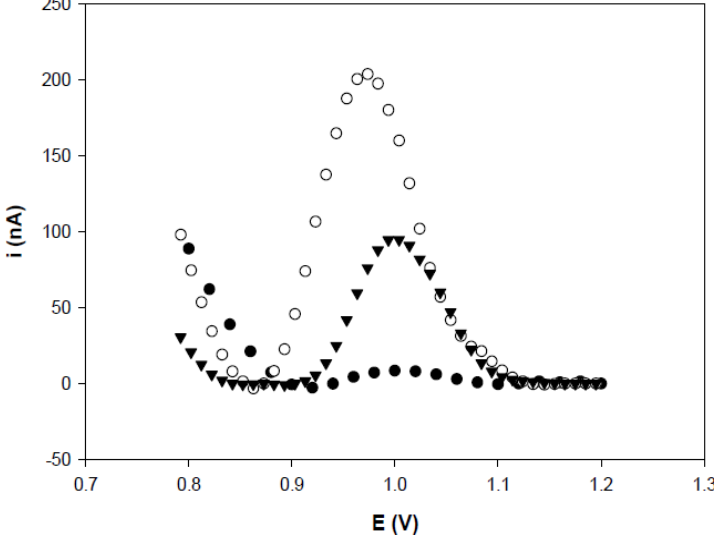
Figure 2. The differential pulse voltammograms of guanine oxidation on (●) an activated PGE, (▼) TS-1T (1 µM) immobilized on an activated PGE and (○) TS-1P (1 µM) immobilized on an activated PGE. Voltammetric conditions: Scanning potential steps, 20 mV/s. Potential amplitude, 50